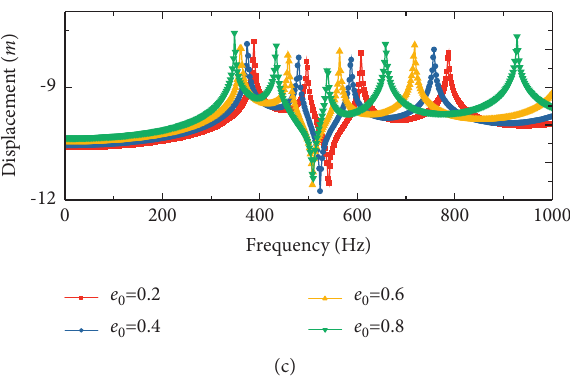
Figure 12: Study on the effect of porous coefficient on the steady-state response of Sandwich FGP doubly curved structure: (a) Sandwich FGP paraboloidal shell; (b) Sandwich FGP hyperbolic shell; (c) Sandwich FGP elliptical shell.